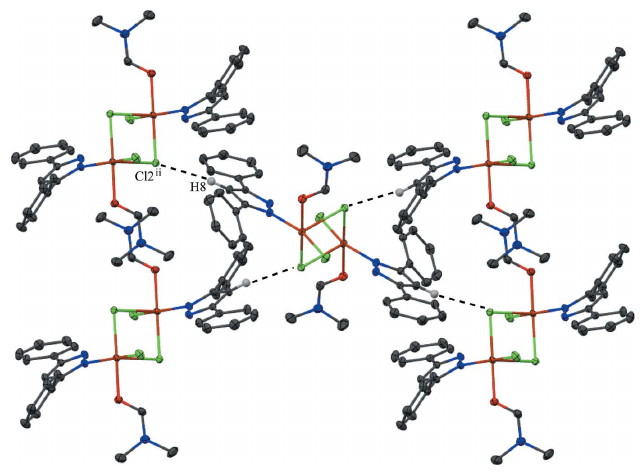
Figure 4 The intermolecular hydrogen bonds present between neighboring molecules of ( 1 ) that result in a two-dimensional sheet [symmetry code: (ii) (cid:4) x + 3 , y + 1 , (cid:4) z + 1 ]. For clarity only the H atoms (white) involved in 2 2 2 the hydrogen bonding are displayed. See Fig. 1 for additional display